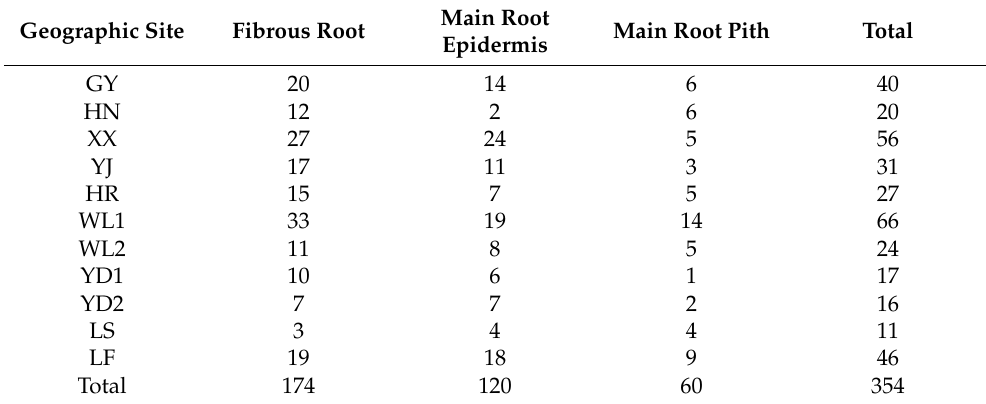
Table 3. Number of F. commune isolates obtained and analyzed from each geographic site and each root tissue type. The detailed root tissue type definitions are provided in Materials and Methods. Geographic Site Fibrous